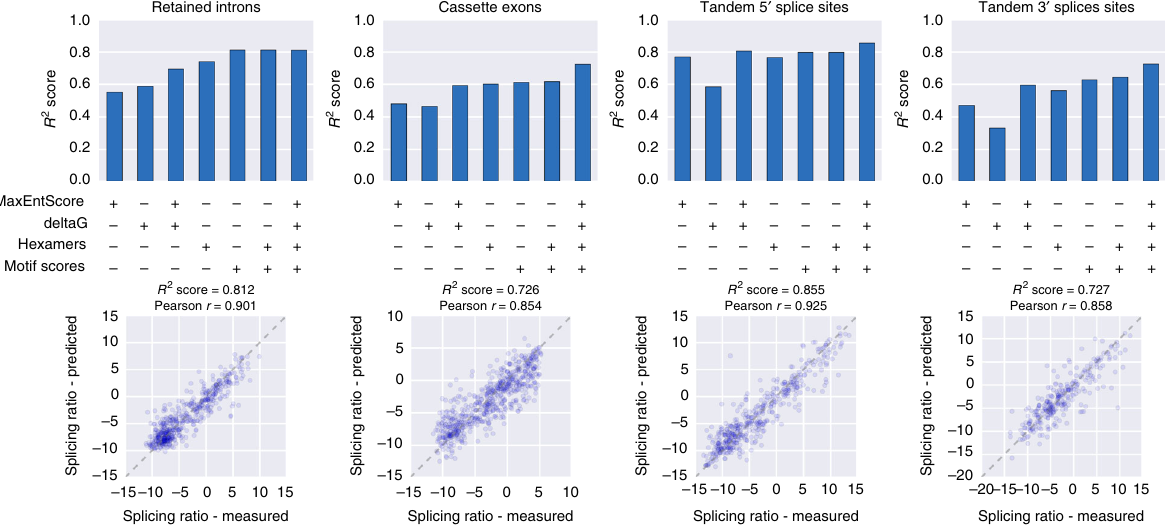
Fig. 4 Accurate prediction of splicing ratios. R 2 scores for predicting splicing ratios of a set of variants not used at any point to build the model (10% of library variants) by Gradient Boosting Regression with the indicated sets of features (top) and measured splicing ratios vs. predictions based on a combination of hexamer counts, RBP motif scores, MaxEntScan scores and secondary structure features (bottom) for the indicated splicing